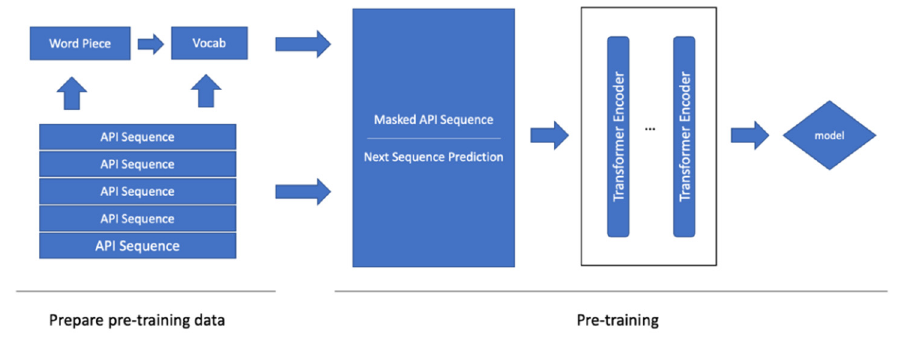
Figure 8. Construction of the pretrained model.